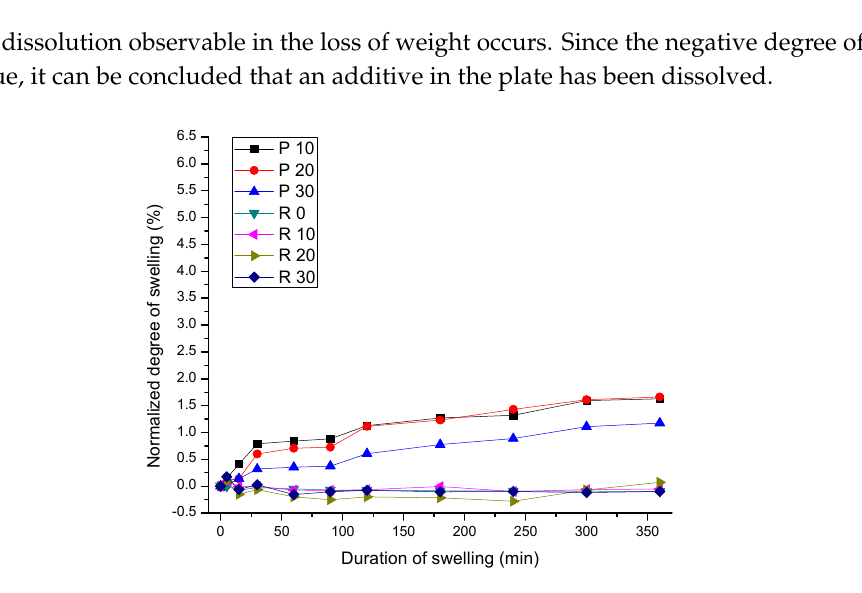
Figure 9. Normalized degree of swelling of the modified photopolymer printing plate samples in IPA.